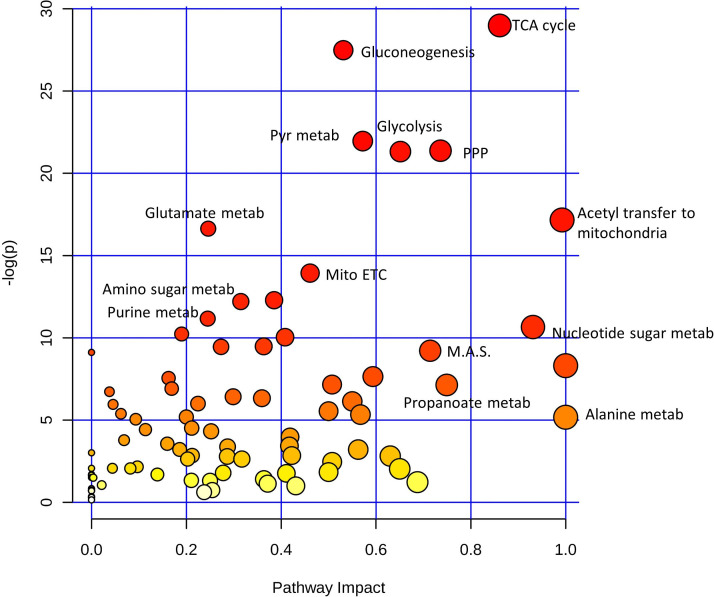
Representation of metabolic pathways based on detected metabolites.Pathway analysis was performed using open source MetaboAnalyst 3.0 software (www.metaboanalyst.ca), using all detected metabolites from the steady state analysis (Figure 3A). Greater warm coloring of a metabolic pathway indicates greater coverage, permitting conclusions to be drawn about that pathway.